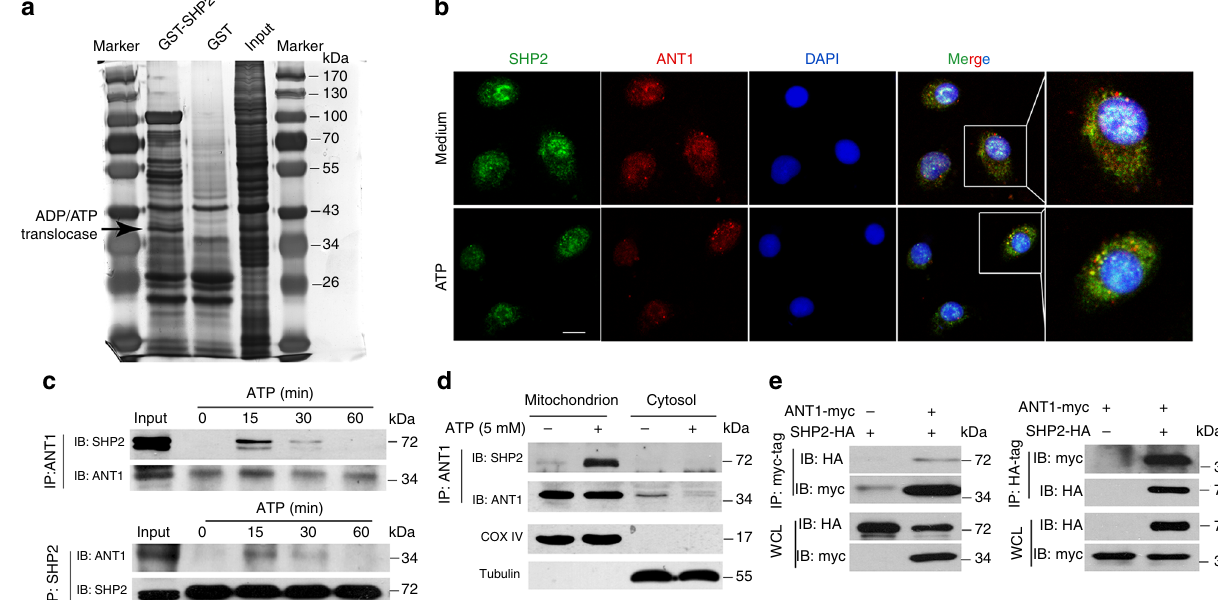
Fig. 5 SHP2 interacts with ANT1 during NLRP3 in fl ammasome activation. a Sliver staining of GST pull-down proteins using GST-SHP2 fusion protein. The proteins interacting with GST-SHP2 were identi fi ed by mass spectrometry. b Immuno fl uorescence analysis of SHP2 and ANT1 from bone marrow-derived macrophages with untreated (medium) or ATP (5 mM, 15 min) treatment. Scale bar, 5 µ m. c Immunoblot analysis of reciprocal co-immunoprecipitation (Co-IP) from THP-1-derived macrophages treated with ATP (5 mM) for indicated times. d Immunoblot analysis of Co-IP from mitochondrial and cytosolic components in THP-1-derived macrophages treated with ATP for 15 min. e Immunoblot analysis of reciprocal Co-IP from HEK293T cells overexpressing